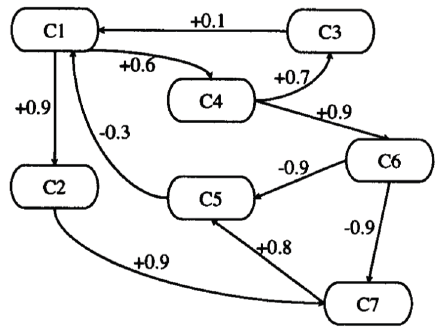
Figure 1. A simple fuzzy cognitive